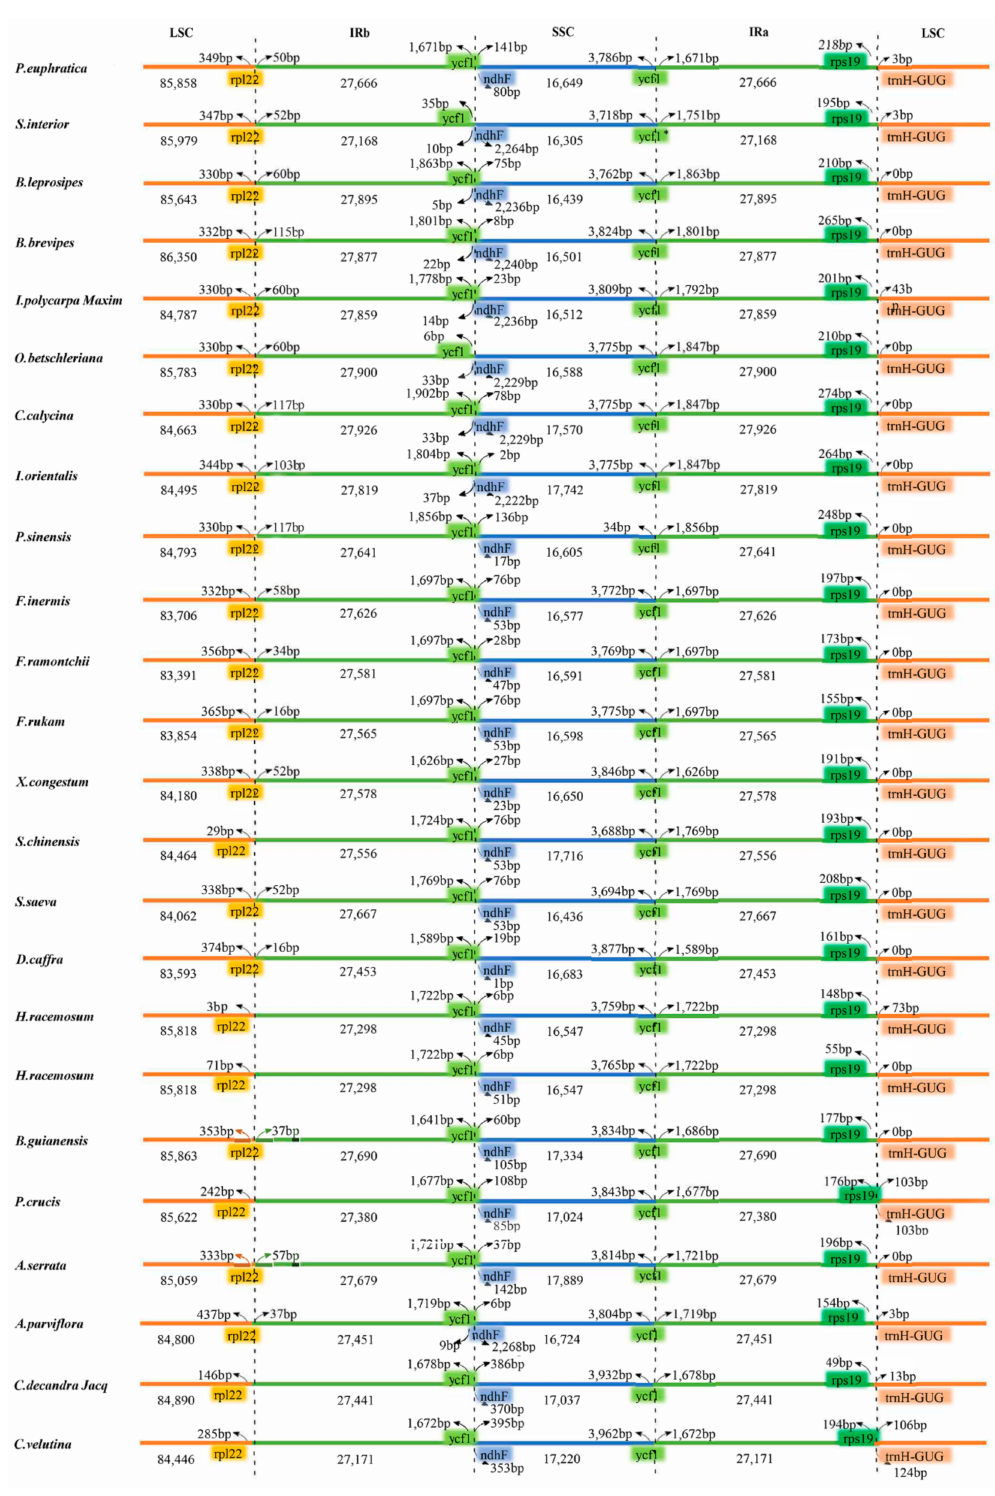
Figure 3. Comparison of the border positions of large single copy (LSC), small single copy (SSC), and inverted repeat (IR) region borders among plastid genomes of 24 Salicaceae s.l. species. Complete genes and portions of genes adjacent to the junctions are depicted by di ff erently colored